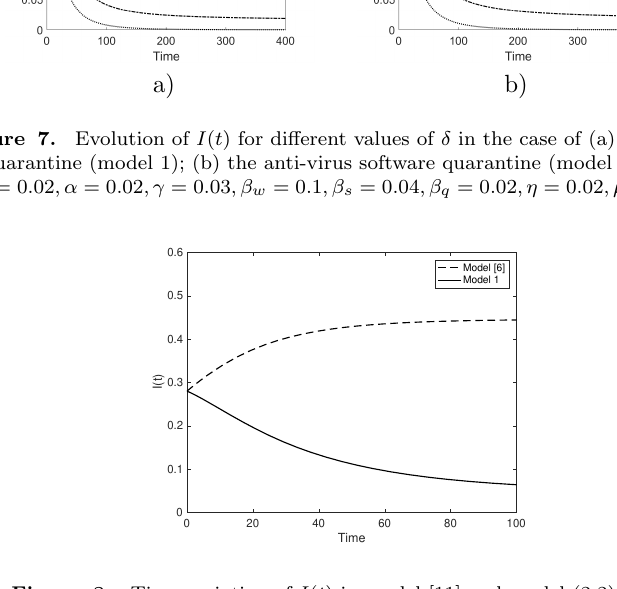
Figure 8. Time variation of I ( t ) in model [11] and model (2.2) where (cid:15) = 0 . 02 ,α = 0 . 02 ,γ = 0 . 03 ,β w = 0 . 1 ,β s = 0 . 04 ,δ = 0 . 027 ,η = 0 . 02 ,µ =